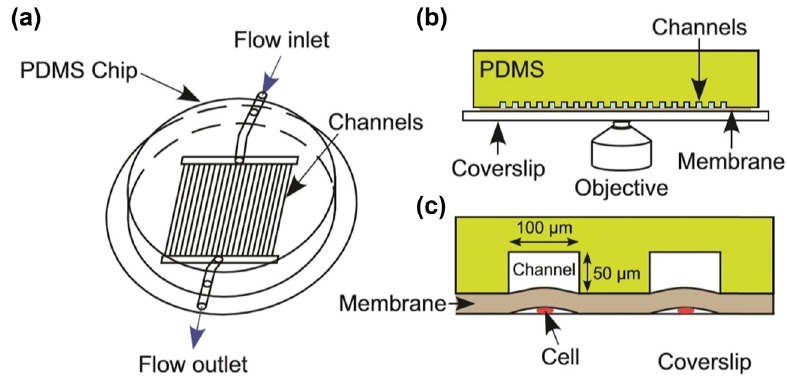
Figure 4: Schematic of the PDMS micro fl uidic chip mounted on a cellulose membrane and a glass coverslip for time - lapse imaging. ( a ) Top view depicting inlet, outlet, and parallel channels. ( b ) Cross - sectional view of the channels in the PDMS chip. ( c ) Closeup to the cells growing in the microchambers, covered by a membrane to allow media di ff usion from the channels. Image reproduced with permission from Science [ 29 ]